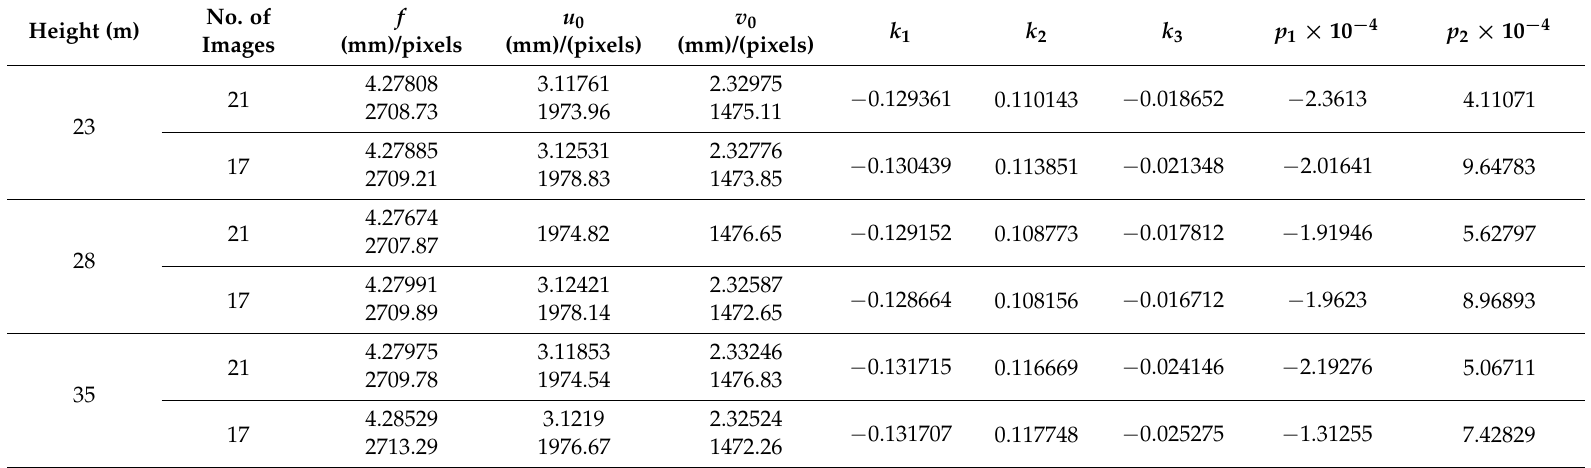
Table 4. Interior orientation parameters calculated for the “GoPro” digital camera at 3 different heights: 23 m, 28 m and 35 m using “Pix 4D Mapper”software. Height